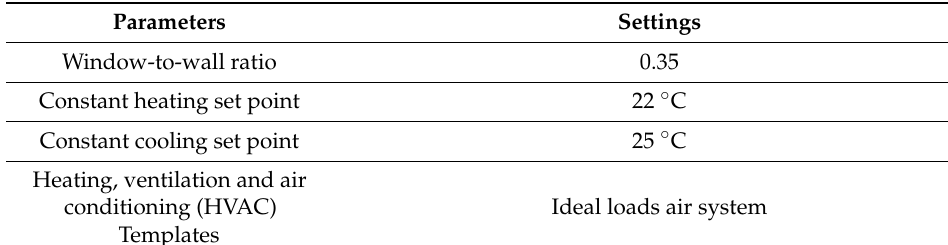
Table 1. EnergyPlus setting parameters for Urban Building Energy